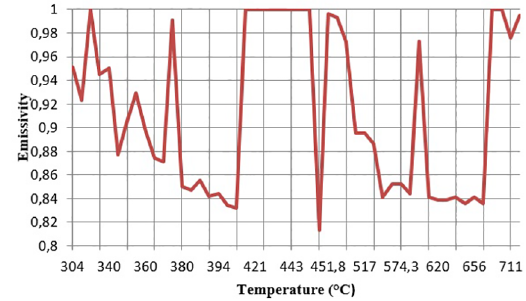
Figure 7. The graph of emissivity versus temperature